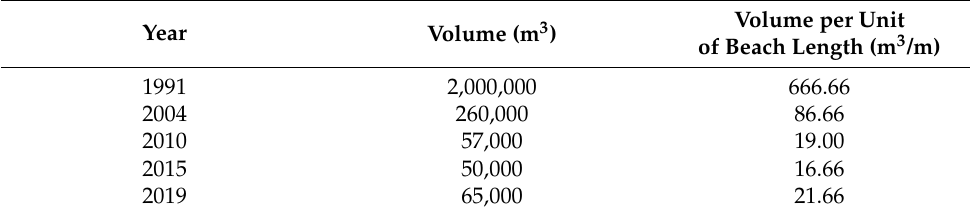
Table 1. Volume of sand (m 3 ) deposited on Victoria Beach in the last three decades